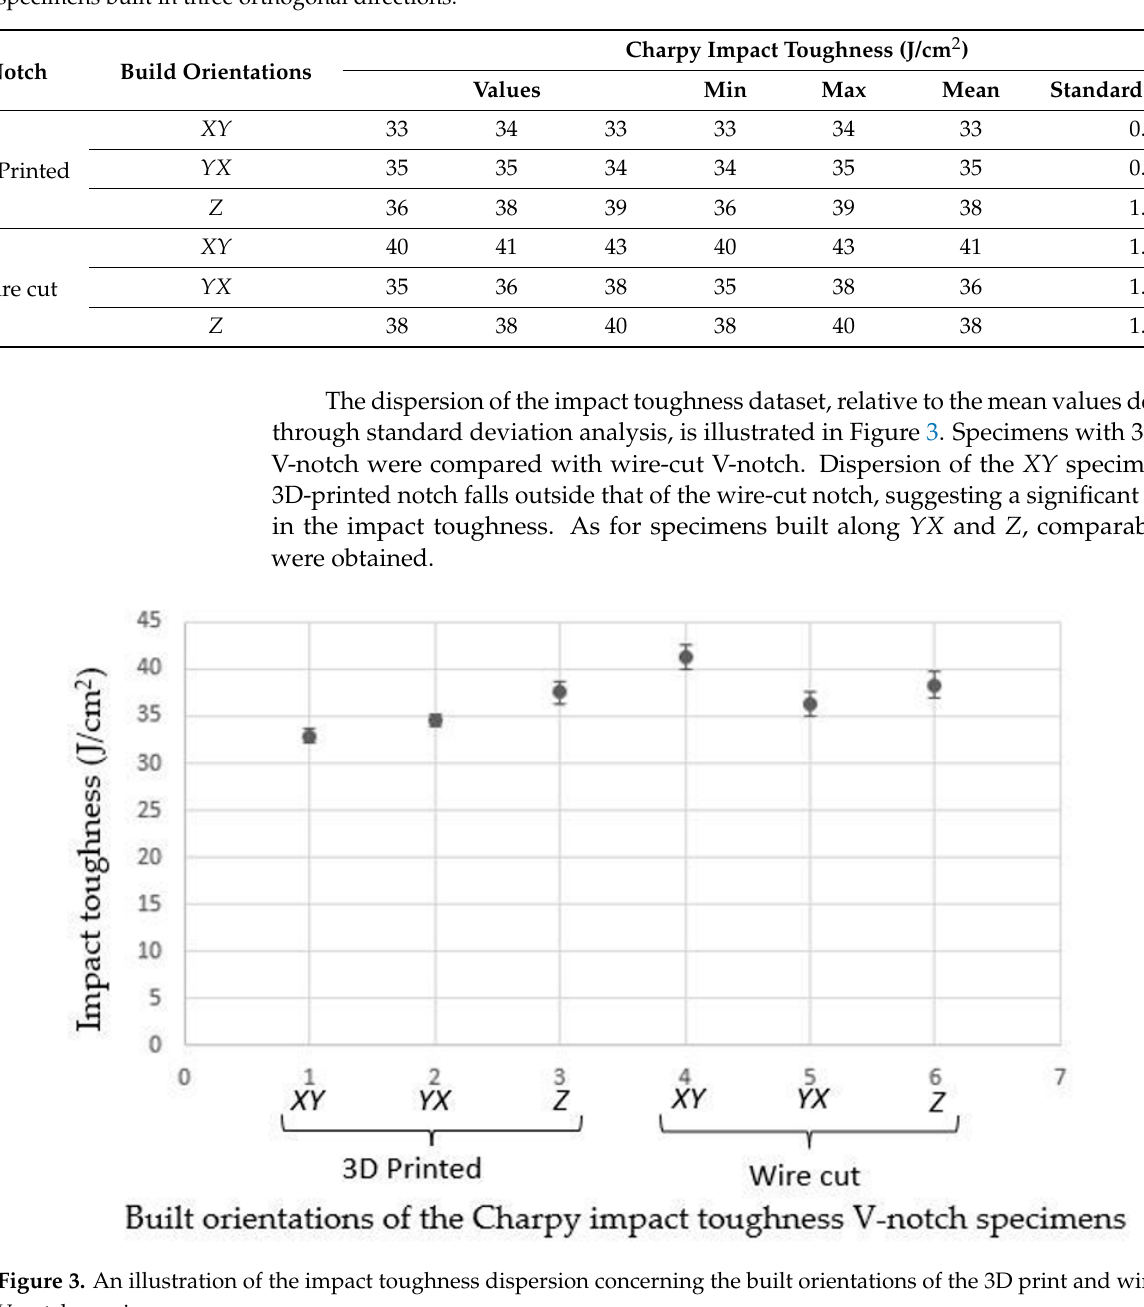
Table 2. Charpy impact toughness in Joule per square centimeter for the 3D-printed and wire-cut V-notch Ti6Al4V(ELI) specimens built in three orthogonal directions.